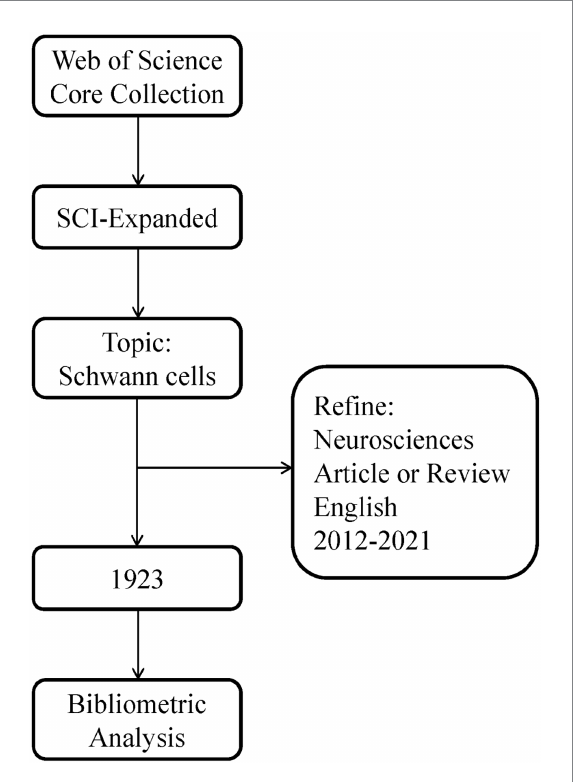
FIGURE 1 Flowchart steps of the search